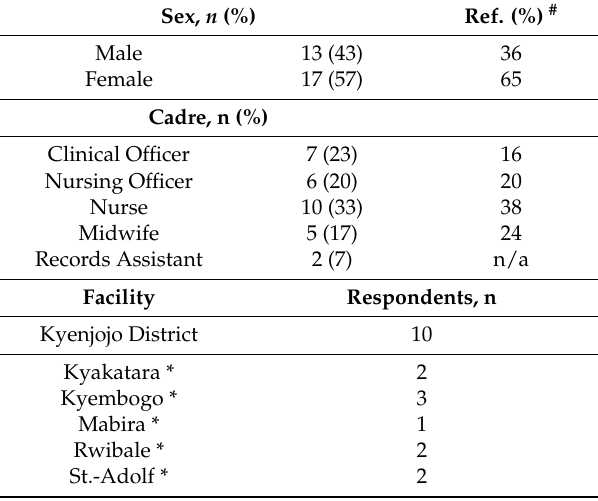
Table 2. Characteristics of health worker respondents ( n =